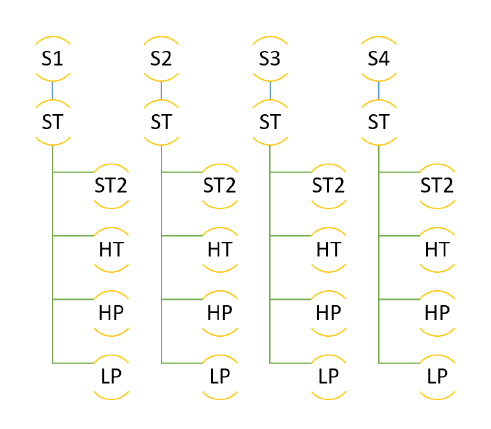
Figure 2. Simulations models for each molecule used in this work. From left to right: C-111, H 2 , DCM and CO 2 .